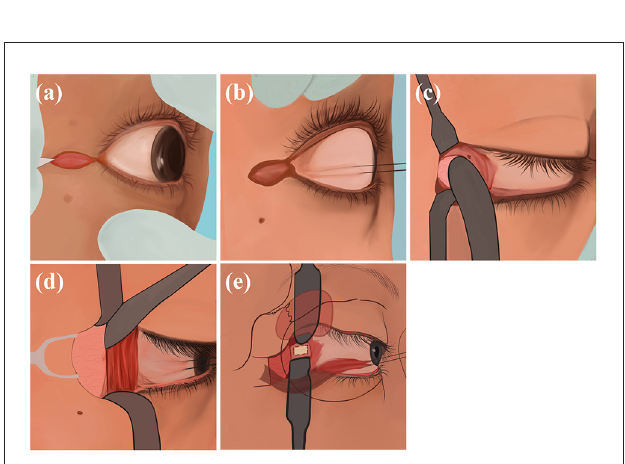
FIGURE4 Transcanthal incision approach: (a) Incise a 1cm lateral canthal incision; (b) use sutures to secure the lateral rectus muscle; (c) separate the overlying periosteum superiorly and inferiorly; (d) expose the eyeball, lift the deep lacrimal gland; (e) expose the optic nerve sheath and make an